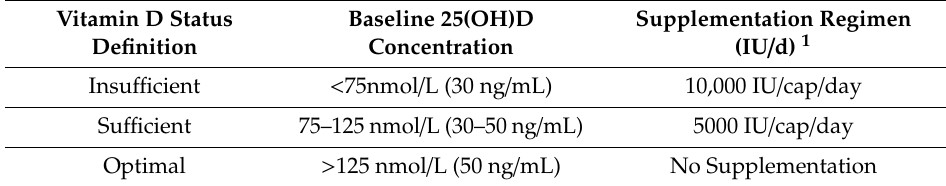
Table 1. Vitamin D supplementation